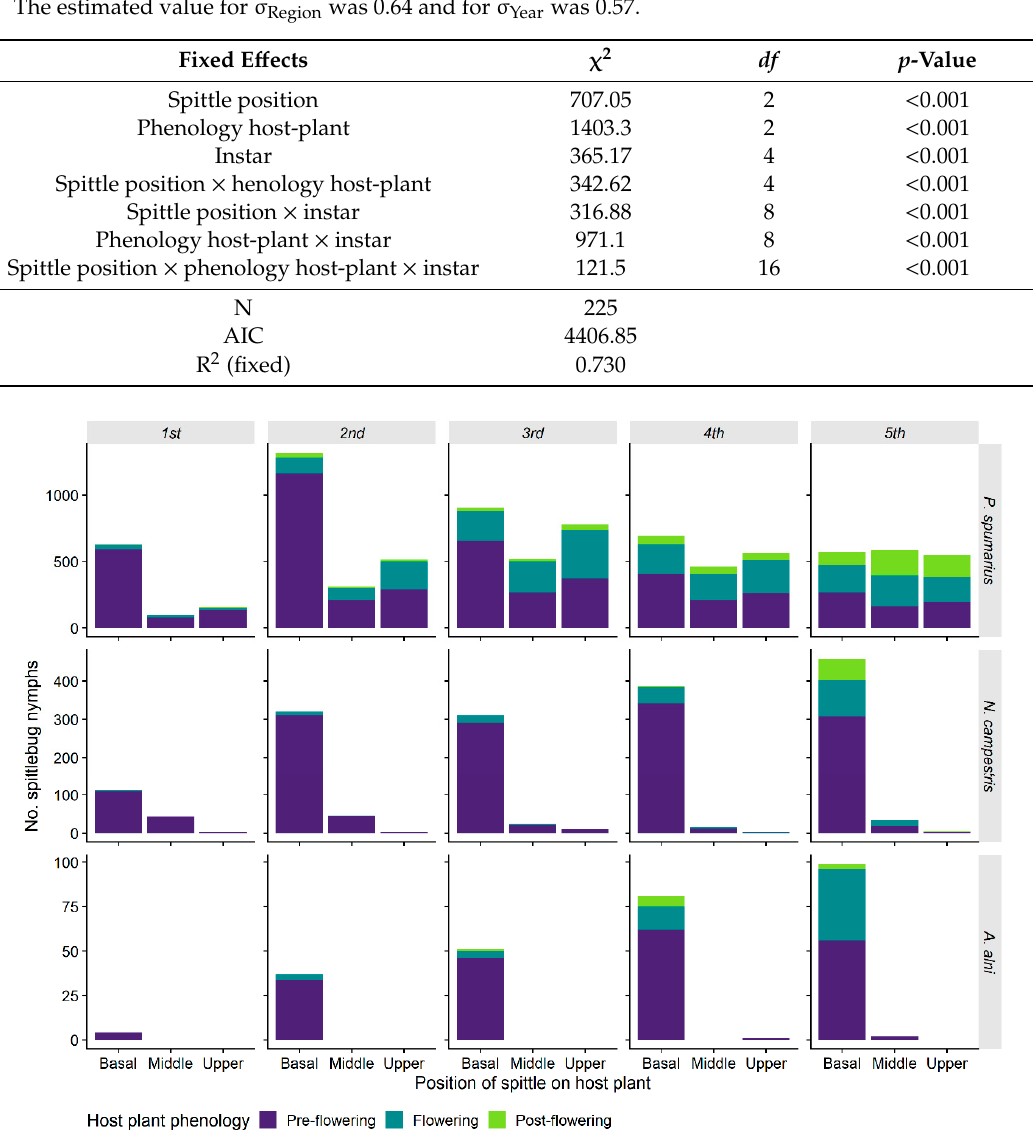
Table 2. E ff ects of fixed covariates on the abundance of Philaenus spumarius nymphs. Poisson GLMM of nymphal counts with covariates spittle position, phenology host-plant, and instar, and their interactions. The estimated value for σ Region was 0.64 and for σ Year was 0.57.